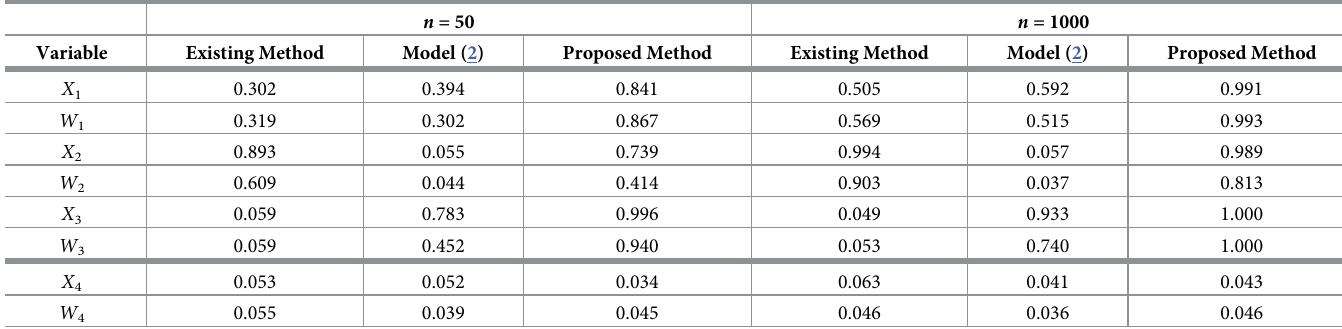
Table 4. Power and type I error comparison for cluster log-normal data ( ρ = 0.4). n = 50 n = 1000